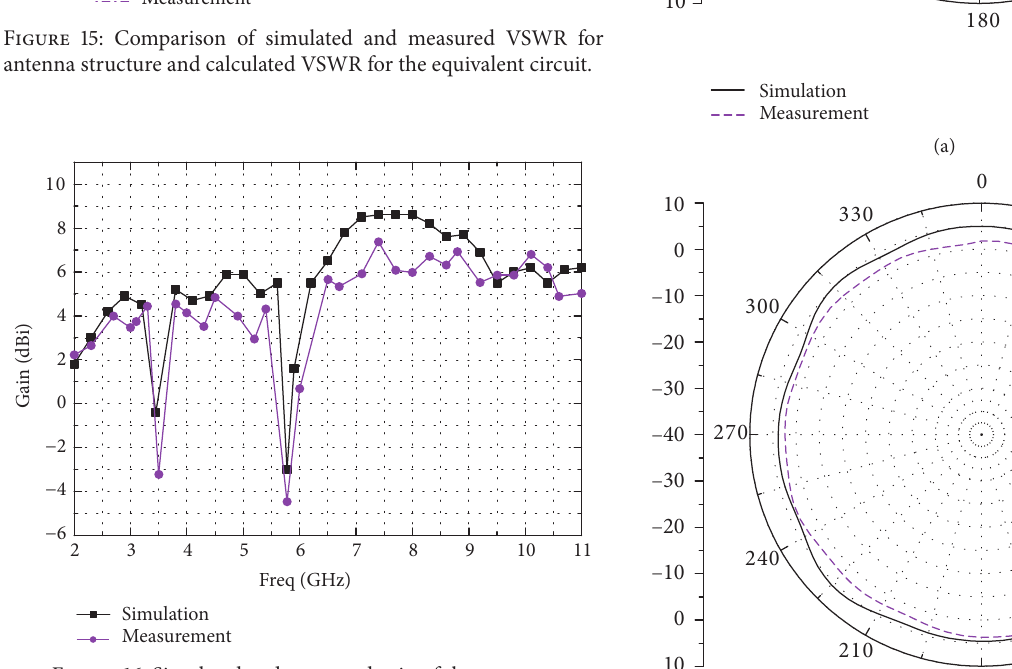
equivalent circuits are identical with the results of simulation and measurement. The realized dual band suppressed UWB antenna shows the omnidirectional characteristic and over 3 dBi antenna gain at frequencies where rejection does not occur. The suggested equivalent circuits provide physical insight into the operational mechanism of band suppressed UWB antennas and also help to bridge the gap between the physical antenna structure and its performance.